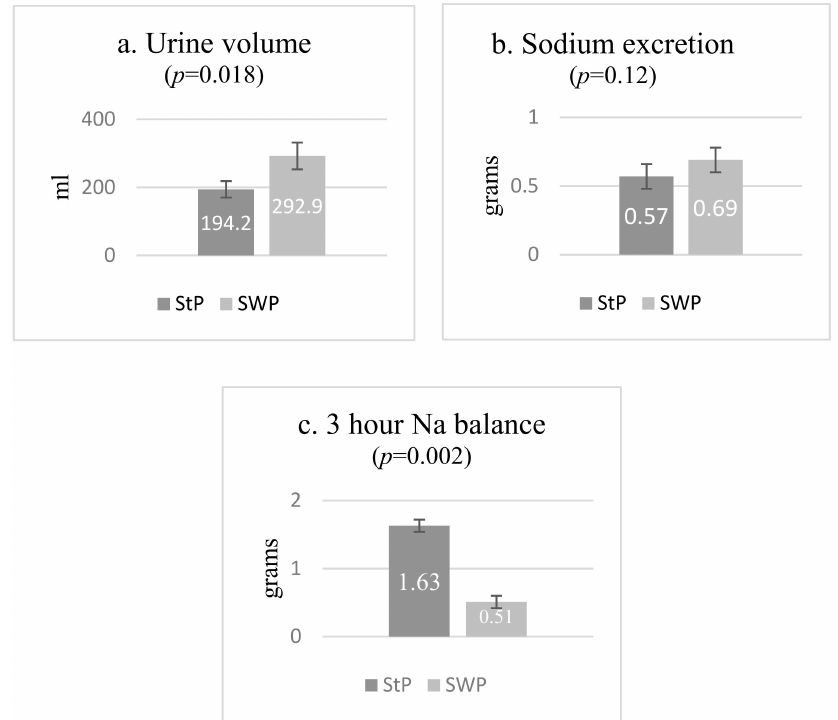
Figure 6. Renal water and Na handling in the 3 h post-meal test. ( a ). Urine volume (mL) collected after 3 h from the consumption of the Standard Pizza (StP) and the Seawater pizza (SWP). p = 0.018. ( b ). Urinary Na excretion (g) after the consumption of the Standard Pizza (StP) and the Seawater Pizza (SWP); p = 0.12. ( c ). Na retention (g) after the consumption of the Standard Pizza (StP) and the Seawater Pizza (SWP); p = 0.002. All results are expressed as mean ± standard error of the mean